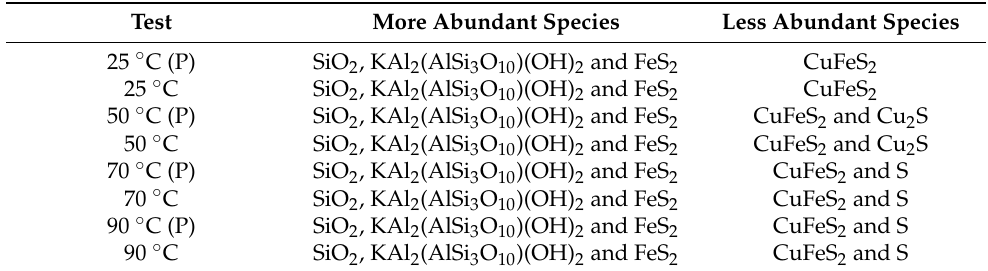
Table 2. Summary of the species identified using X-ray diffraction analysis. Tests with pretreatment samples are indicated by